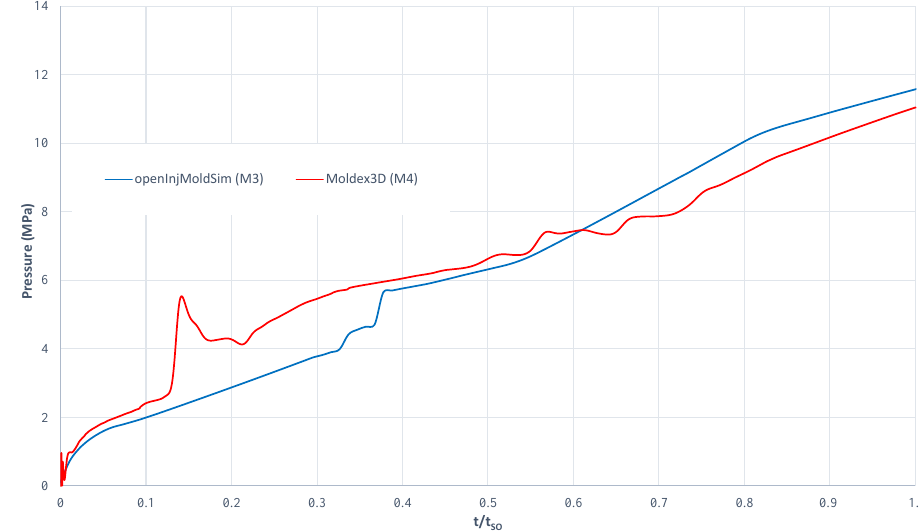
Figure 11. Time evolution of the inlet pressure obtained with the most refined mesh for both (cid:13) openInjMoldSim and Moldex 3 D R [11]